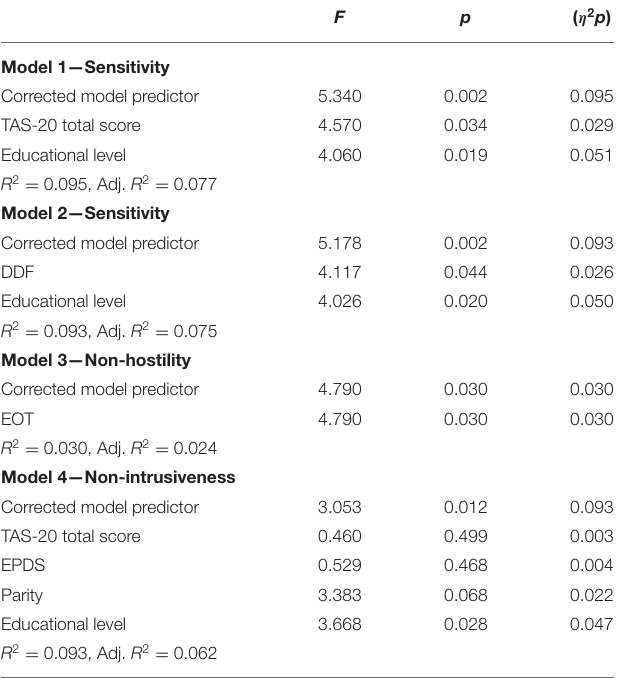
TABLE 3 | Associations between the Emotional Availability Scales Sensitivity, Non-hostility and Non-intrusiveness and alexithymic traits with associated background factors and potential confounders explored by General Linear